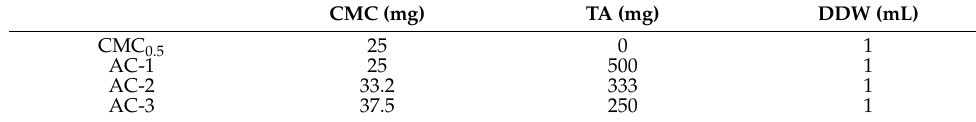
Table 1. Precursor compositions of different AC hydrogels.